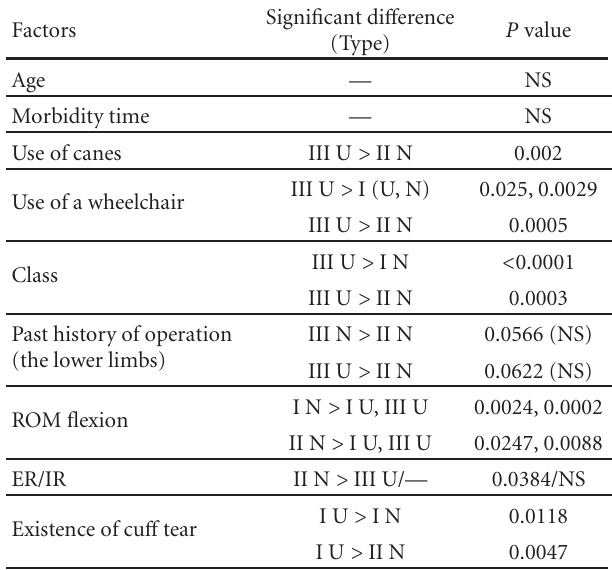
Table 3: The relationship between this particular classification and certain patient